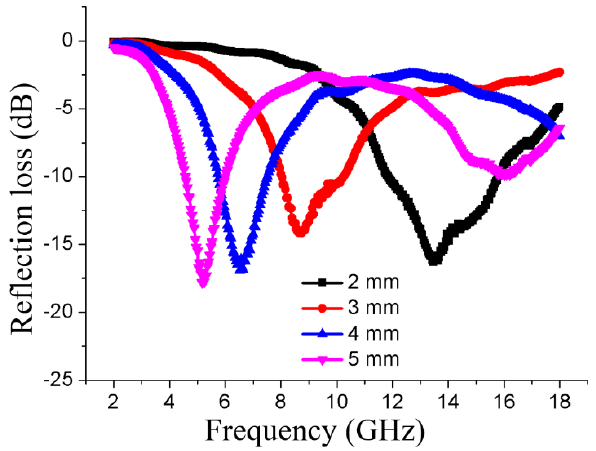
Figure 4. The reflection loss curves of the 3-layer composite magnetic board fabricated by a magnetic fiber core with the thickness from 2 mm to 5 mm.